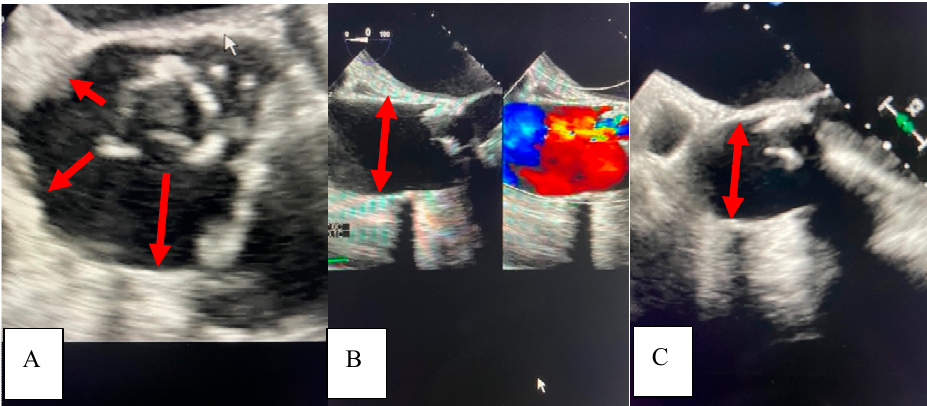
Figure 2. TEE demonstrating well-seated tissue bioprosthetic valve with normal 2D/Doppler function. Panel ( A ), Omniplane at 45 degrees. Panel ( B ), Omniplane at 125 degrees. Panel ( C ), Omniplane at 0 degrees. In each panel, note the enlarged root and “stretching” of the aorta away from the annulus indicated by the red arrows.